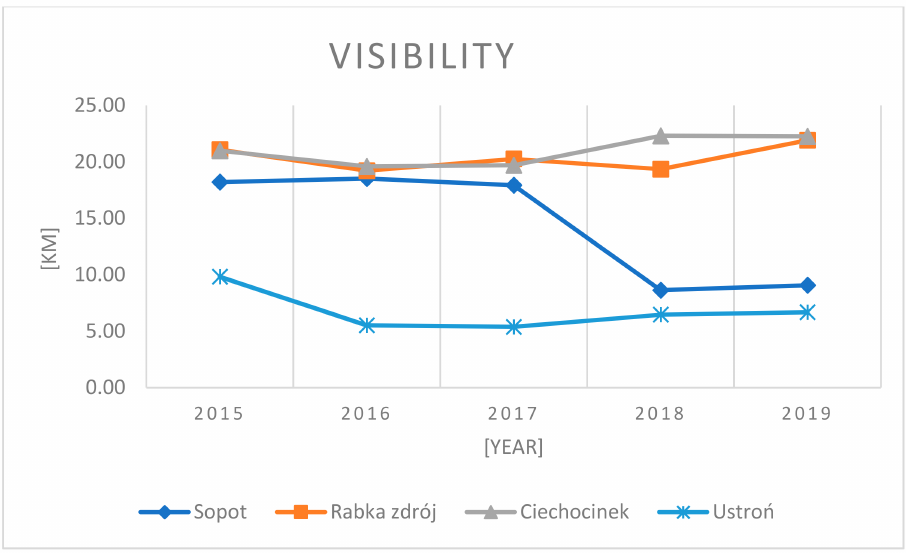
Figure 5. Average annual visibility for health resorts communes in 2015–2019.